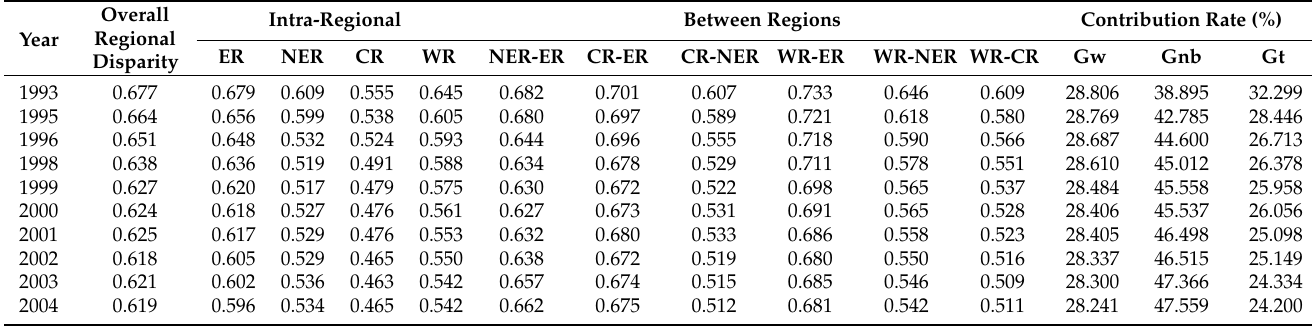
Table 2. DG coefficient and its decomposition of the